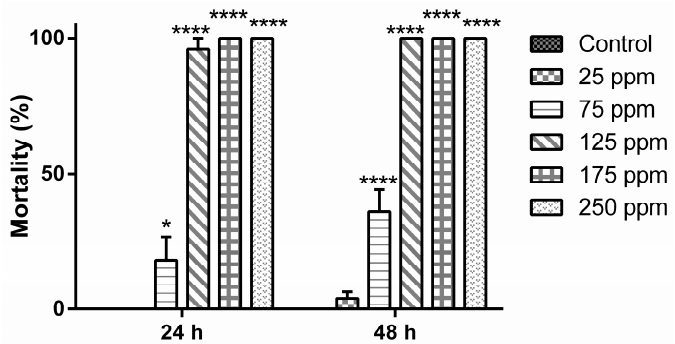
Figure 2. Mortality levels (%) of Aedes aegypti (early fourth-instar larvae) after treatment with D -limonene -based nanoemulsion. Significance: * p < 0.05; **** p < 0.0001.